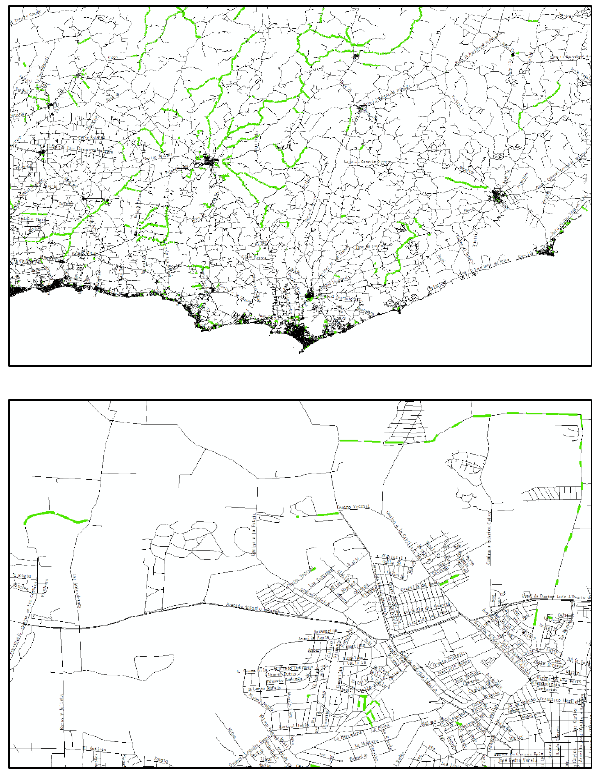
Figure 6 . Attribute supplementary test results